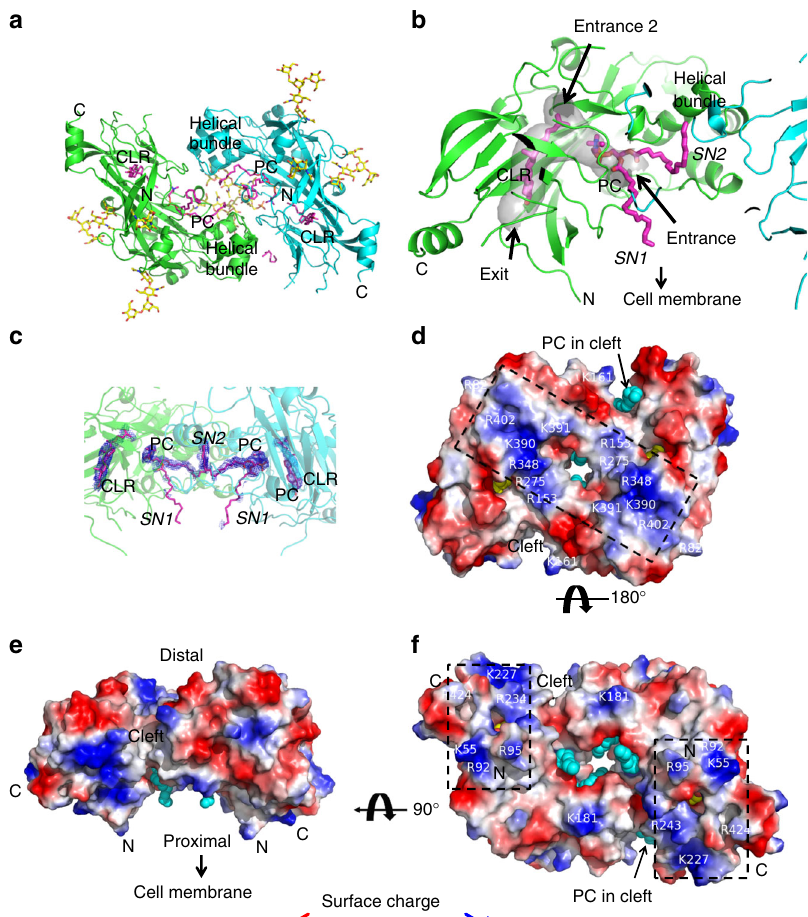
Fig. 1 Structure of lipids bound LIMP-2 dimer. a Lipid-bound LIMP-2 adopts a dimeric structure. The twofold axis of the dimer is perpendicular to the plane of the fi gure at the center. Protein ribbons are colored green and cyan for different subunits. Endogenous ligands, recognized as phosphatidylcholine (PC) and cholesterol (CLR), are shown in stick model, with carbon atoms colored magenta, oxygen red, nitrogen blue, and phosphorus orange. Carbon atoms in glycan moieties are colored yellow. Image prepared using pymol 60 . The N and C termini and the helical bundles are labeled. b Zoomed-in view of one of the hydrophobic tunnels (calculated using program caver 61 ) in the LIMP-2 dimer; the entrances/exit to the hydrophobic tunnel are indicated by arrows. Bound lipids with their relative orientation to the cell membrane, and the helical bundle of the second subunit are indicated. Exit and entrance 2 are the proximal and distal openings highlighted in Fig. 2d. c PC and CLR molecules in the hydrophobic tunnel are shown embedded in 2mFo-DFc composite omit map (blue mesh) contoured at 1.0 σ . d – f Surface electrostatic potential presentations of the LIMP-2 dimer. Color bar indicates blue positive and red negative charges, with neutral shown in white. Bound ligands in view are shown in yellow spheres for CLR, and cyan for PC, and cleft bound PC is indicated. Surface cationic patches are enclosed in dashed boxes and residues forming these patches are labeled. d The putative distal face of the LIMP-2 dimer. e Side view of the dimer. Orientation of the luminal domain relative to the cell membrane is indicated. f The putative cell membrane proximal face of the LIMP-2 dimer. Notice that CLR molecules are visible through openings on both the distal ( d ) and the proximal ( f ) faces. a and f , and c and e have the same views, respectively. For clarity, glycans are omitted in d –